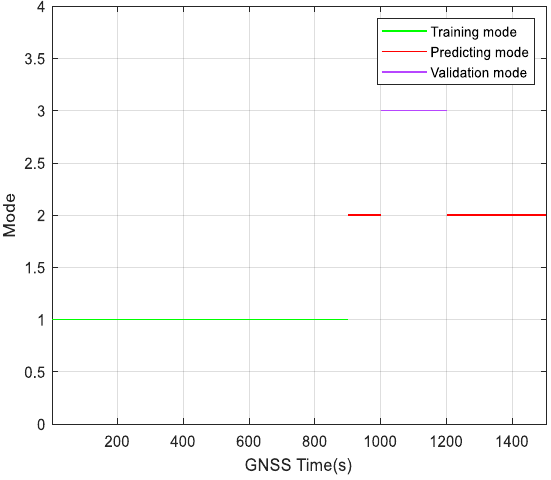
Figure 15. Transitions between modes of the virtual sensor.